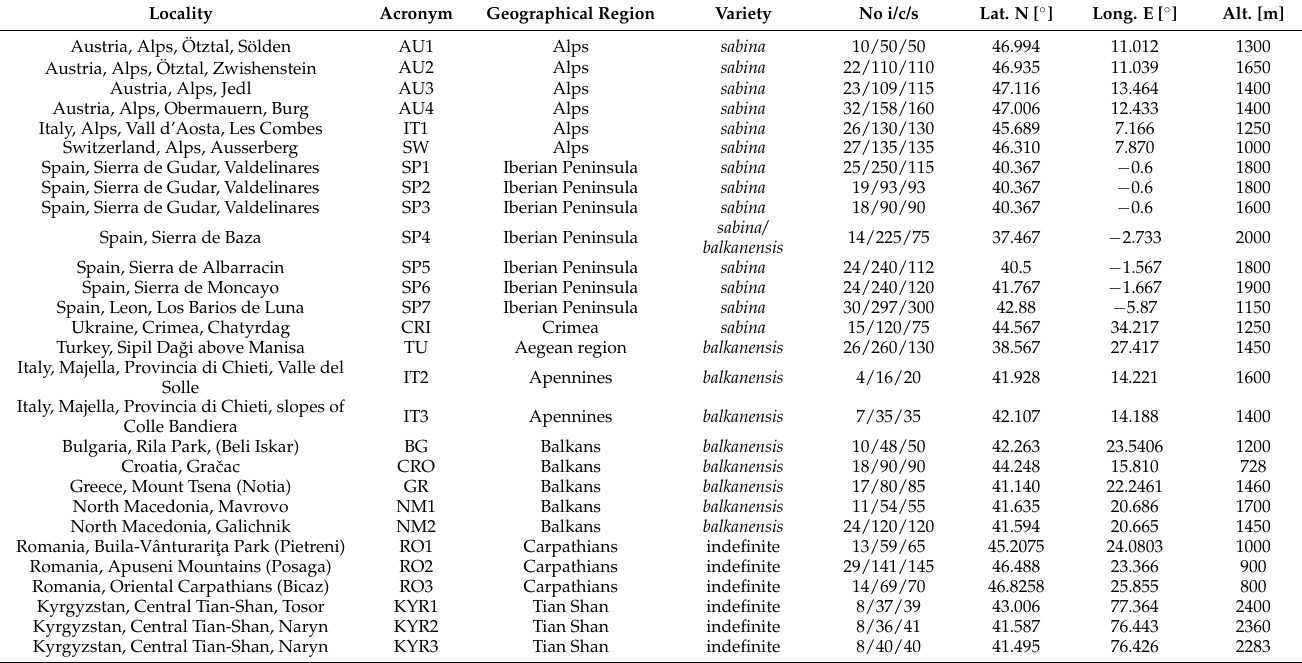
Table 1. Sampled populations of J. sabina with their geographic location, variety assignment and number (No) of analysed individuals (i), cones and seeds (c) and shoots (s).